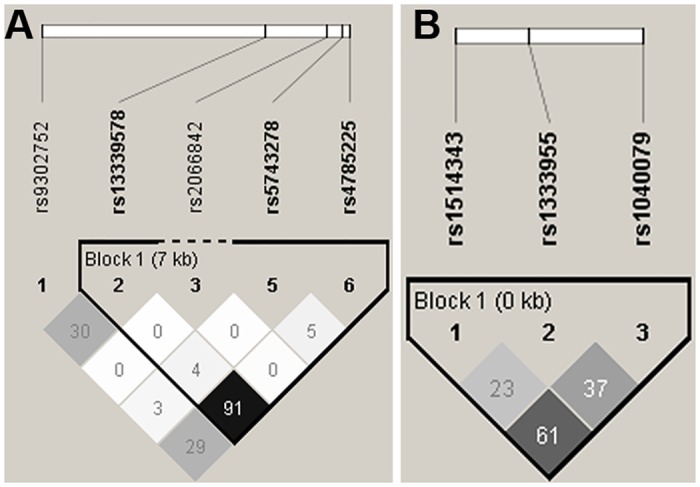
Haploview pairwise analysis of Linkage Disequilibrium (LD) between NOD2 gene SNPs (A) and PARK2 gene SNPs (B).The r2 colour scheme was used. Measures of r2 = 0 are represented in white (not significant); 0<r2<1 are represented in shades of grey; r2 = 1 are represented in black (significant). The numbers inside the box indicate the r2 in a percentage version. An r2 of 0 indicates complete linkage equilibrium, whereas an r2 of 1 indicates complete LD.